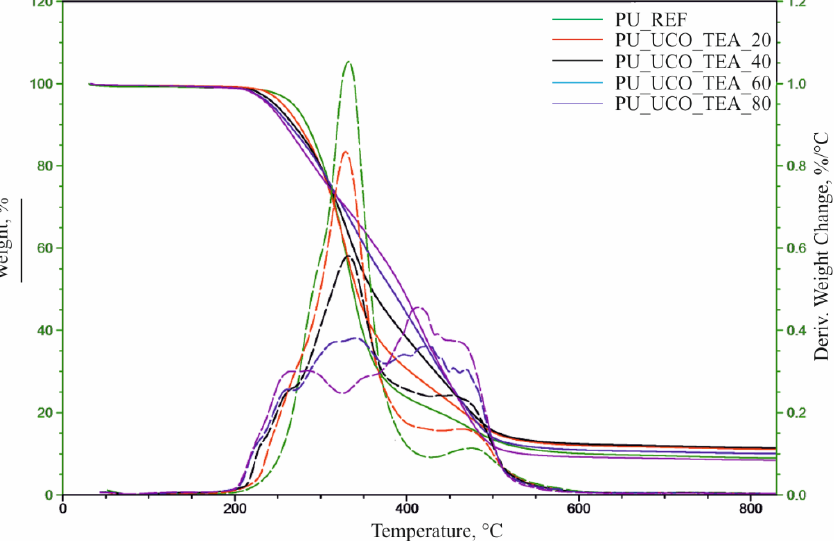
Table 6. Results of DSC analysis.